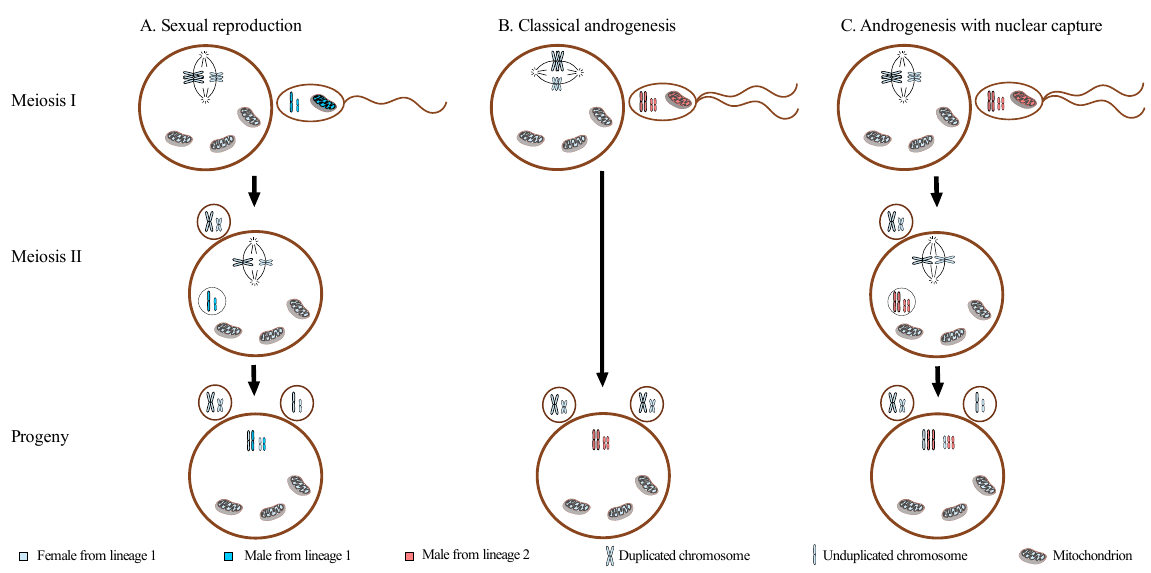
Figure 1: Possible outcomes of nuclear DNA through meiosis in Corbicula genus. Although this is variable in metazoans (Sagata 1996), fertilization occurs during meiosis I in Corbicula (Obata et al. 2006; Komaru et al. 2006). The mitochondrial DNA is inherited maternally. A. In sexual species, a two-step meiosis leads to the production of a reduced haploid egg. Its fertilization by uniflagellate reduced sperm gives diploid progeny from both maternal (light blue) and paternal (dark blue) nuclear DNA (Obata et al. 2006). B. In androgenetic Corbicula lineages, all the maternal nuclear DNA is usually extruded within polar bodies during meiosis I (meiotic axis parallel to the adjacent cortex, see Komaru et al. 1998), and the sperm is biflagellate and unreduced. The progeny is thus diploid from paternal nuclear DNA only. If this occurs between two distinct lineages (here represented in blue and red), this leads to a mitochondrial mismatch. C. In androgenetic lineages, the maternal DNA exclusion can also be incomplete, producing a triploid progeny with both maternal and paternal nuclear DNA (Komaru et al. 2006). If occurring between distinct lineages (blue and red), this leads to hybridization. For clarity, only two chromosome sets are represented (different size and edge thickness) and the gamete sizes are not to